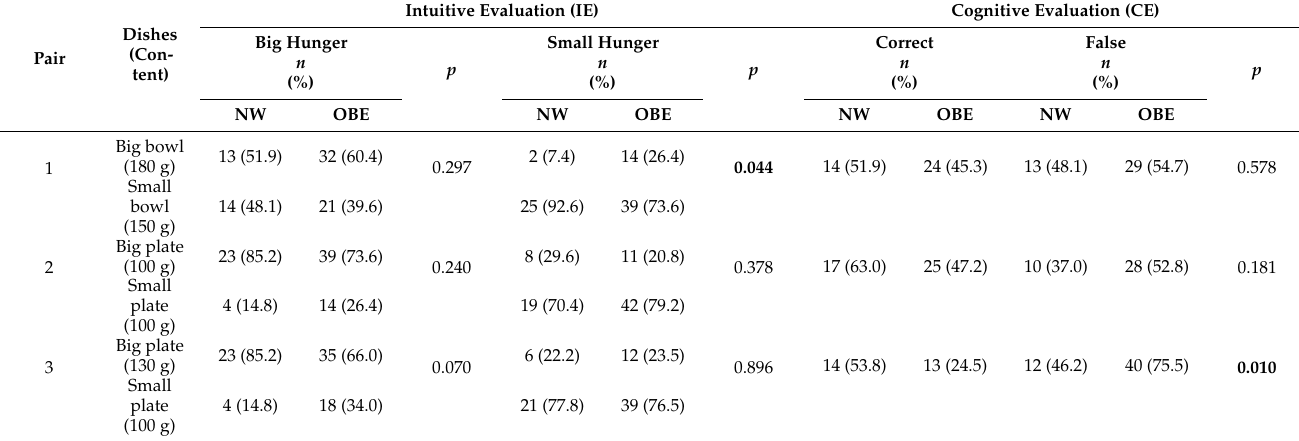
Table 4. Results of the intuitive and cognitive evaluation for